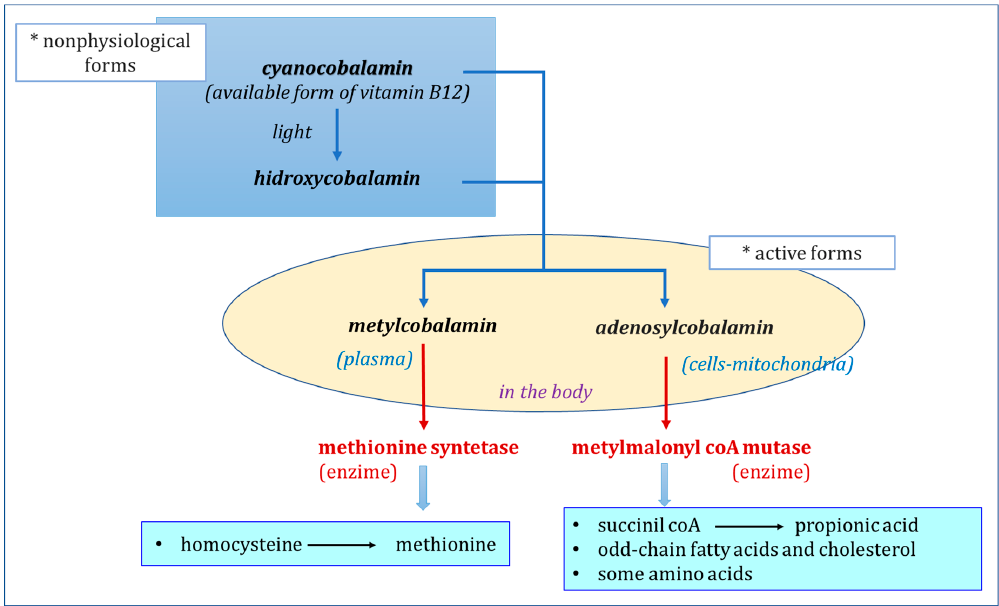
Figure 2. The forms of vitamin B12 and their role in mammalian metabolism. CoA: coenzyme A.